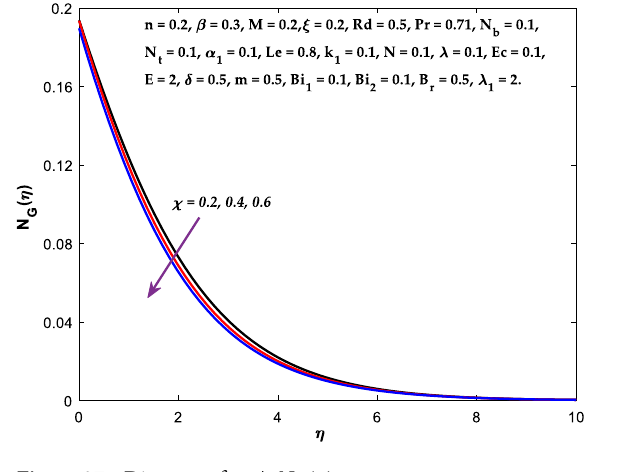
Figure 27. Diagram of χ v/s N G (η) .